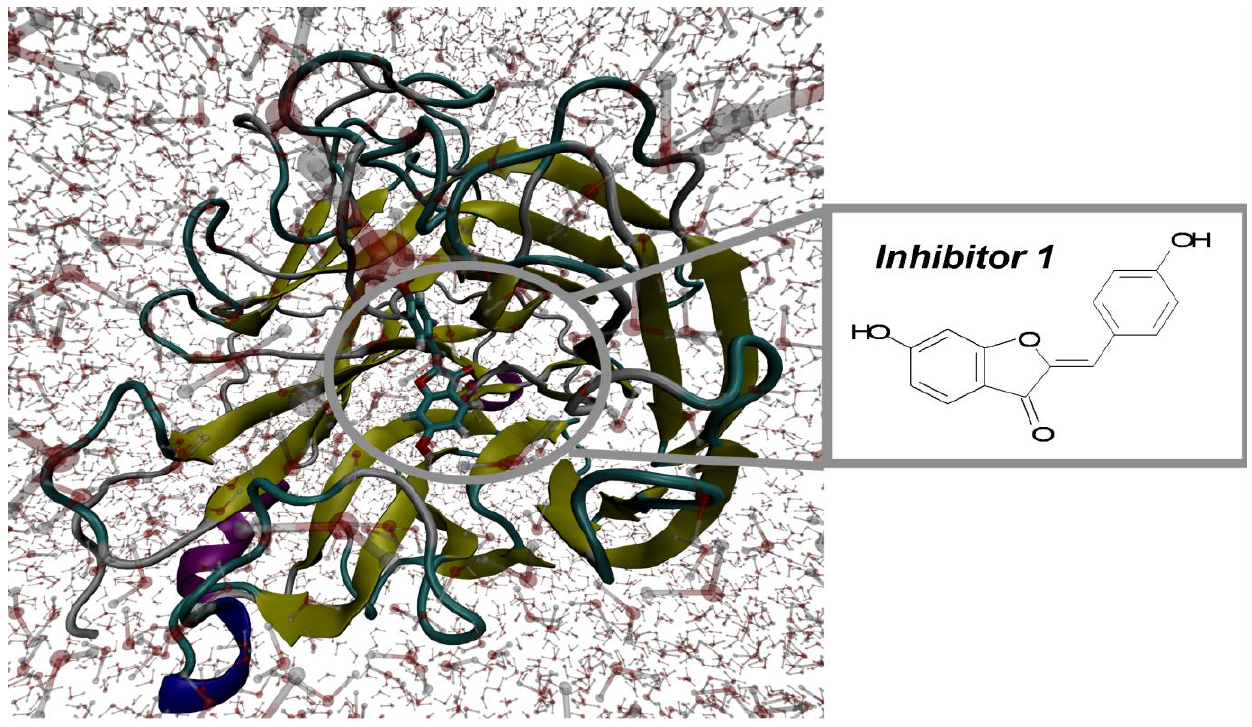
Figure 2. The snapshot of the 2009 H1N1 neuraminidase of the inhibitor